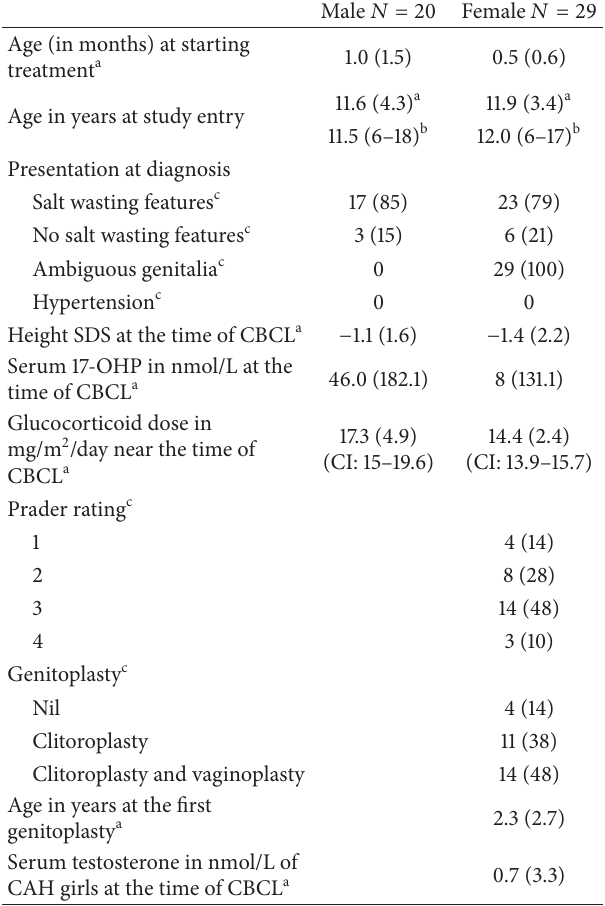
Table 1: Disease characteristics of CAH